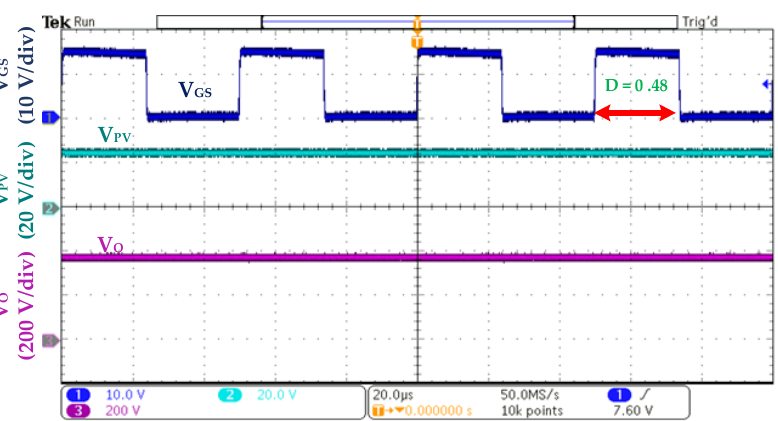
Figure 17. Experimental waveform for the gate source voltage (V GS ), solar photovoltaic simulator output voltage (V PV ), and output voltage (V o ) for the proposed HVGSU converter at the 0.48 duty cycle (Hor: 20 µs/div).